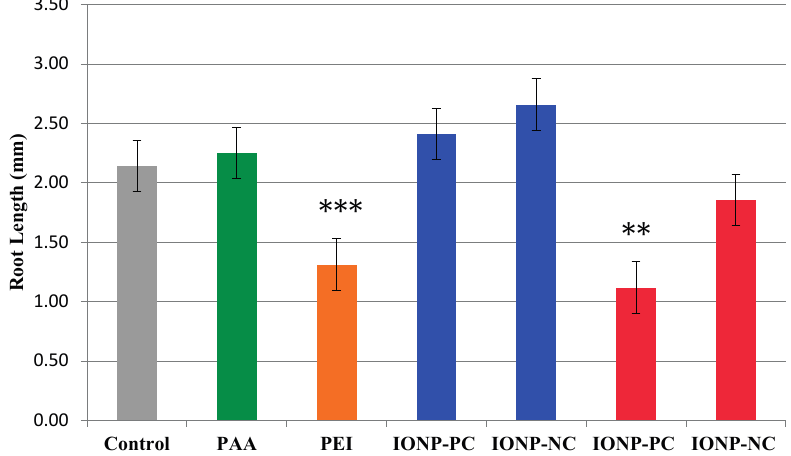
Figure 3. Changes in A. thaliana seedling root length after exposure to IONPs. Seeds were grown in MS media supplemented with either INOP-PC or IONP-NC at concentrations of 3 µg/mL (blue) or 25 µg/mL (red); or PAA only (green) or PEI only (orange) at 12.5 mg/L and compared with growth media only control (gray), Root lengths were measured six days after planting. Treatments with significant difference of p < 0.009 are marked with two asterisks; p < 0.0001 are marked with three asterisks. For all treatments n = 74